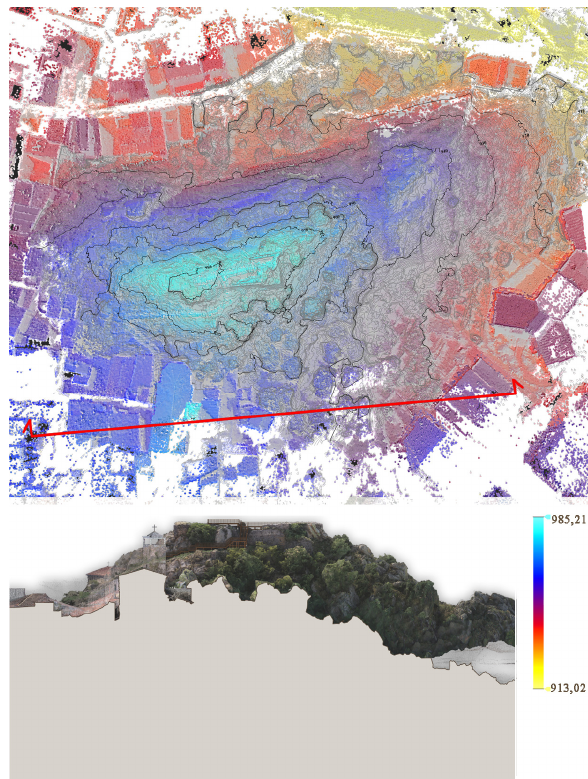
Figure 3 . Maletto Castle. Planimetric and altimetric readings of the